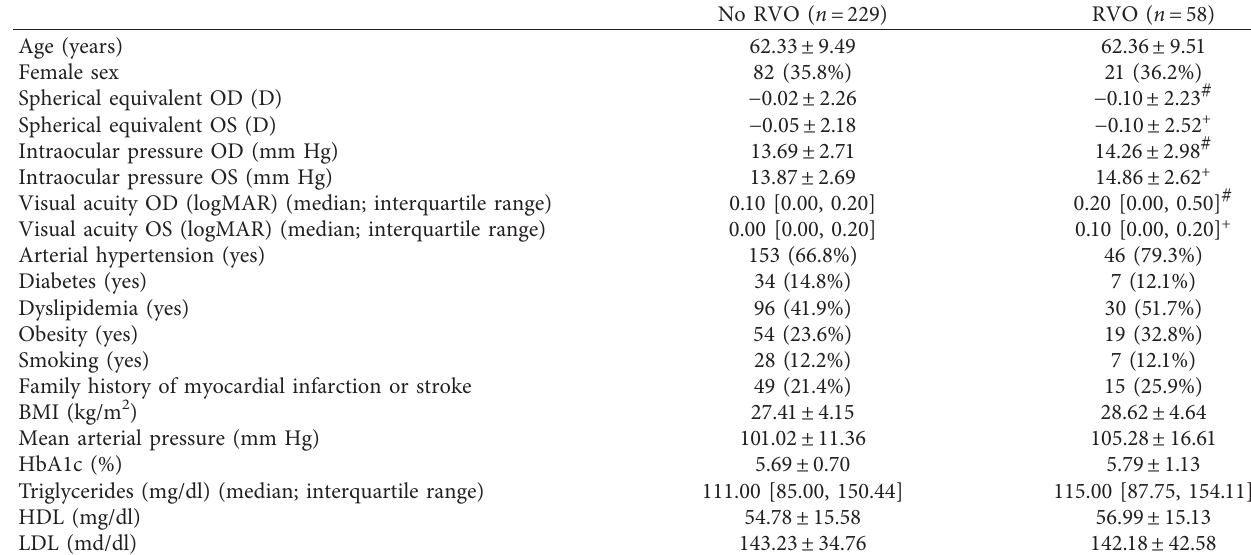
Table 1: Characteristics of the study sample of the German population-based Gutenberg Health Study (GHS),